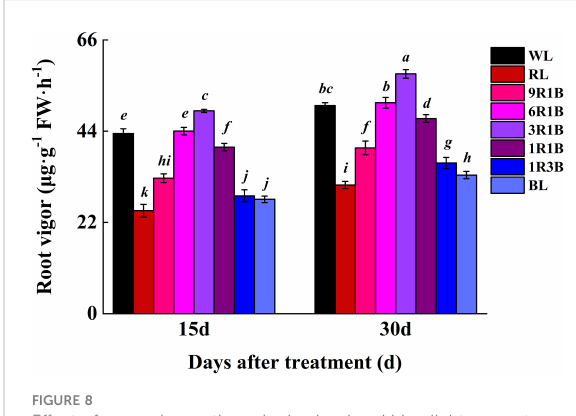
FIGURE 8 Effect of monochromatic and mixed red and blue light on root vigor of sweet pepper seedlings at day 15 and 30 after treatment. Difference in lower-case letters indicates signi fi cant difference at P <